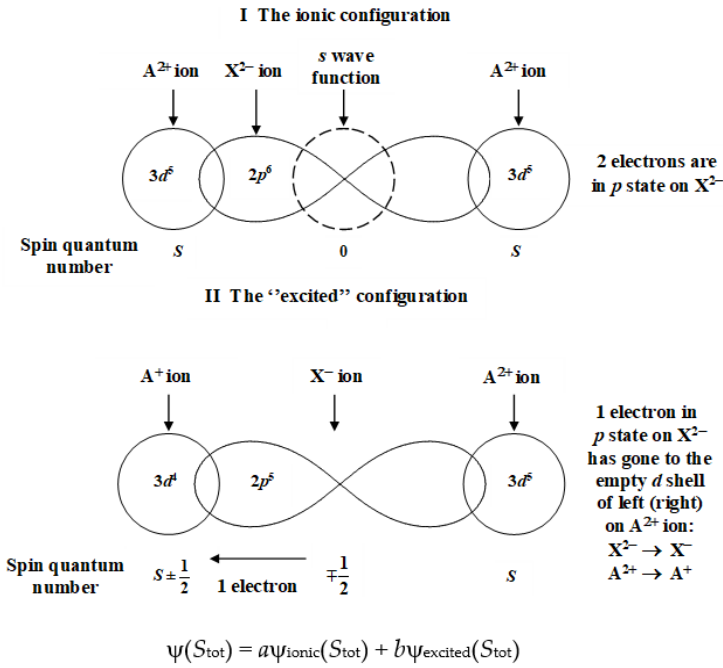
Figure 2. “Ground” and “excited” configurations in the original superexchange process for the sequence A–X–A; the electronic configuration of the valence shell has been added for each ion (in our case, A = Mn, X = O, for instance); due to the weak overlap, coefficients a and b are small. In the present case, the electronic transfer is from X to A but it can also occur from X to B, indifferently (here, B =